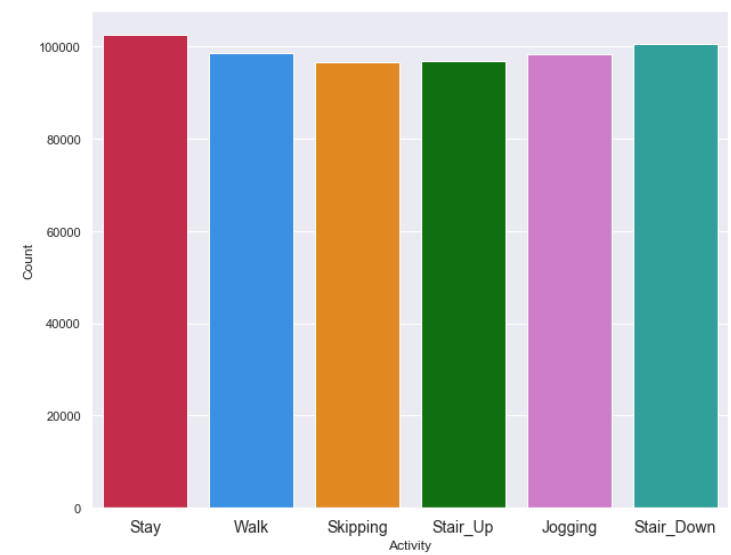
Figure 5. Activity record count in HASC clean dataset.